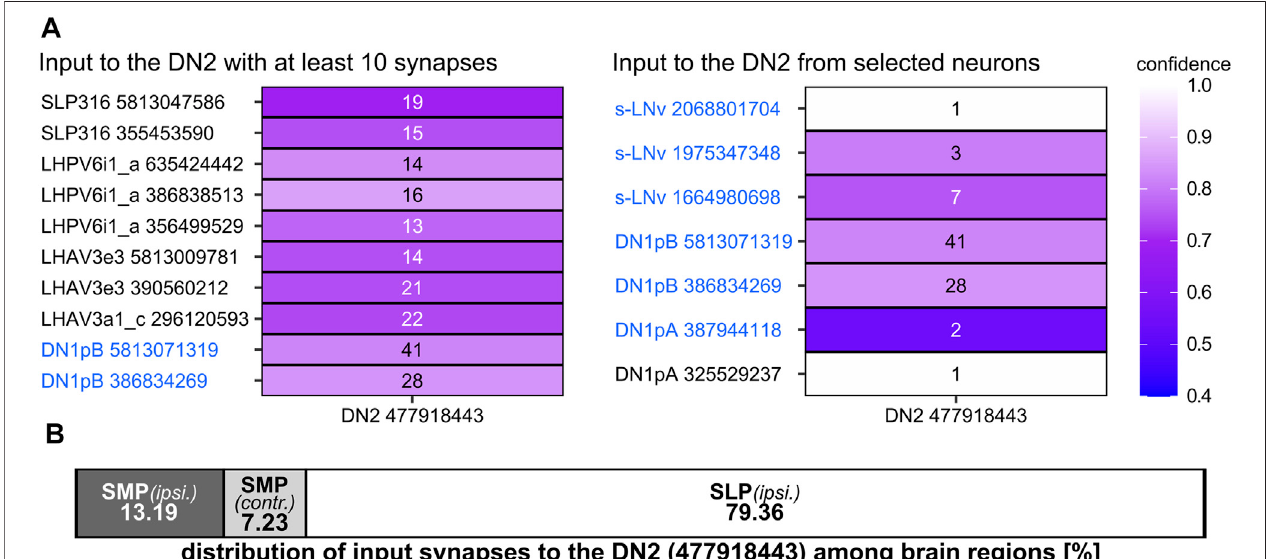
FIGURE13| PresynapticpartnersofDN 2 #477918443andthedistributionofpostsynapticsynapsesamongthebrainregions. (A) PresynapticpartnersoftheDN 2 with at least 10 synapses and selected clock neurons as presynaptic partners. The DN 2 gets input from neurons with their cell bodies located in the superior lateral protocerebrum (SLP)aswellasinthelateral horn(LH).Additionally,theDN 2 gets inputfromtheCRY-positiveDN 1p sasalreadyvisibleinthepostsynapticpartnersofthe CRY-positiveDN 1p s.Further,itgetsweakinputfromsomes-LN v s. (B) DistributionoftheDN 2 postsynapticsynapses(input)amongthebrainregions.TheDN 2 gets around 80% of the input in the ipsilateral SLP and only around 20% of the input in the ipsilateral (ipsi.) or contralateral (contr.) SMP.